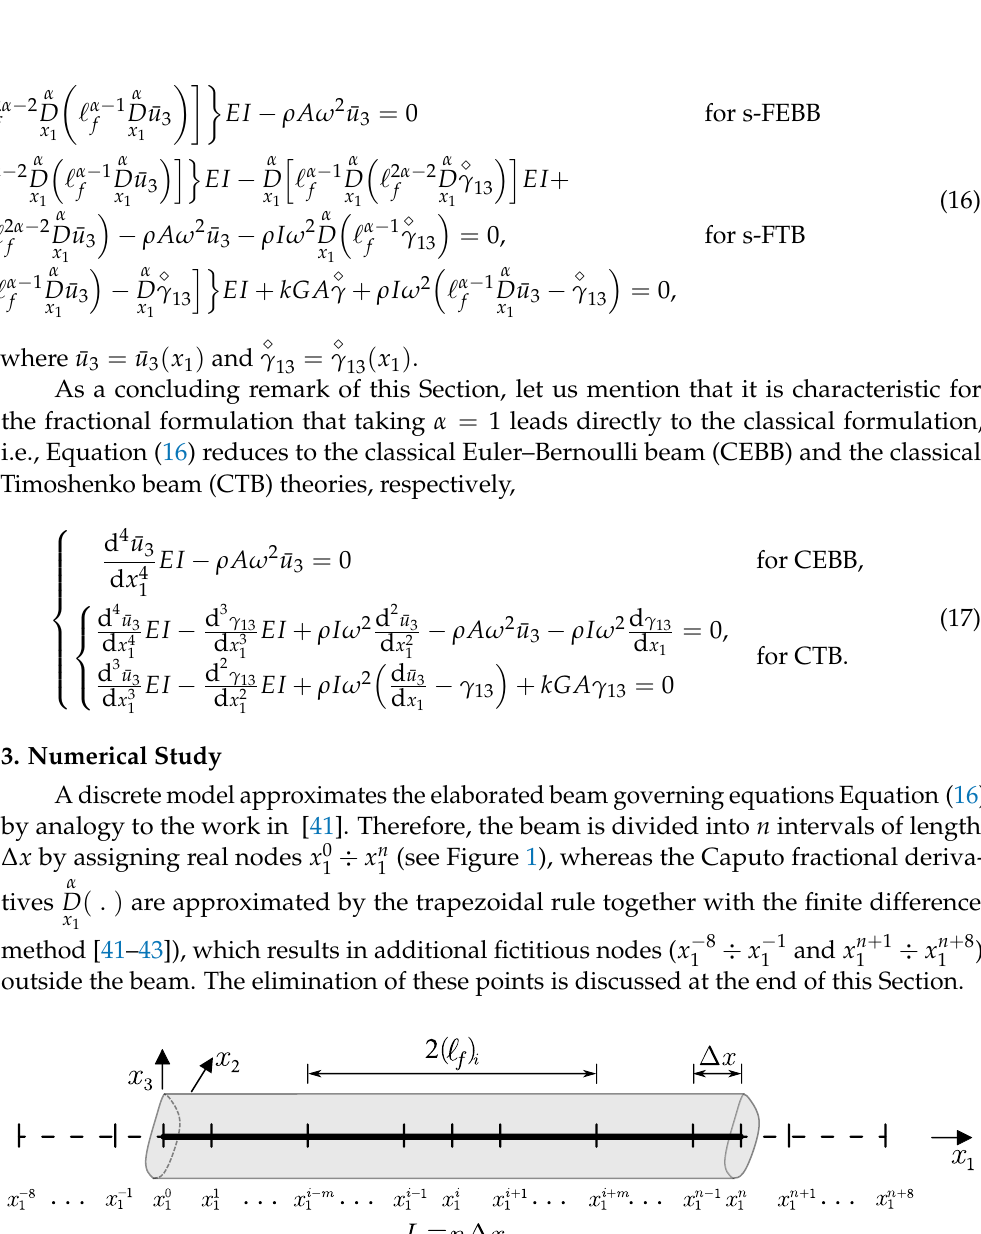
Figure 1. Discretization of the analyzed beam of length L —homogeneous grid: real nodes x 0 fictitious nodes x − 8